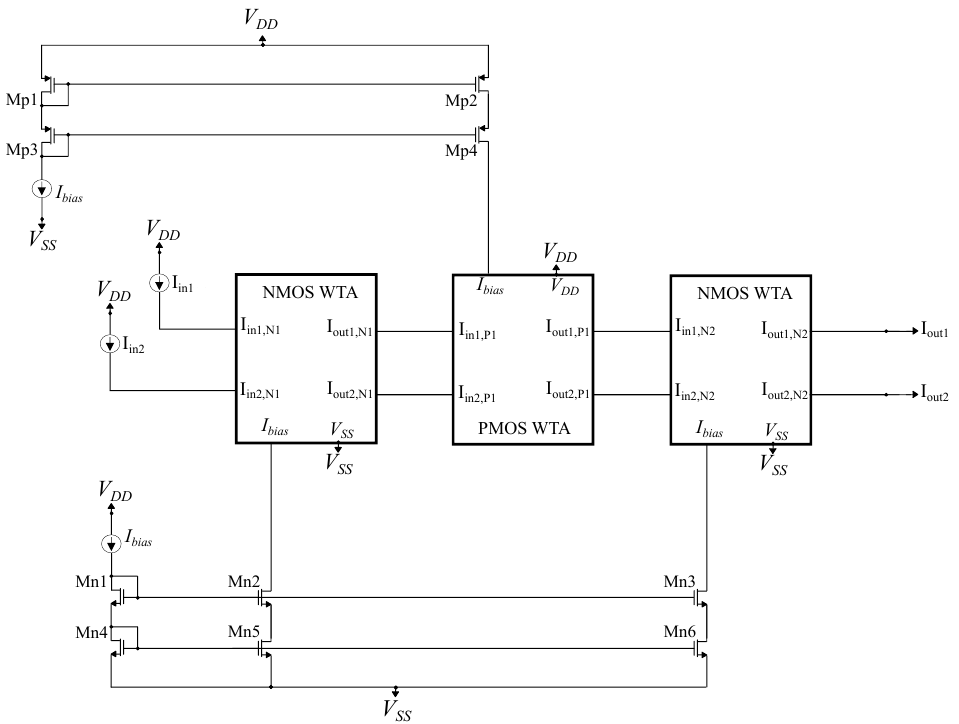
Figure 13. The implemented triple cascaded WTA circuit built by alternating the simple NMOS and PMOS WTA